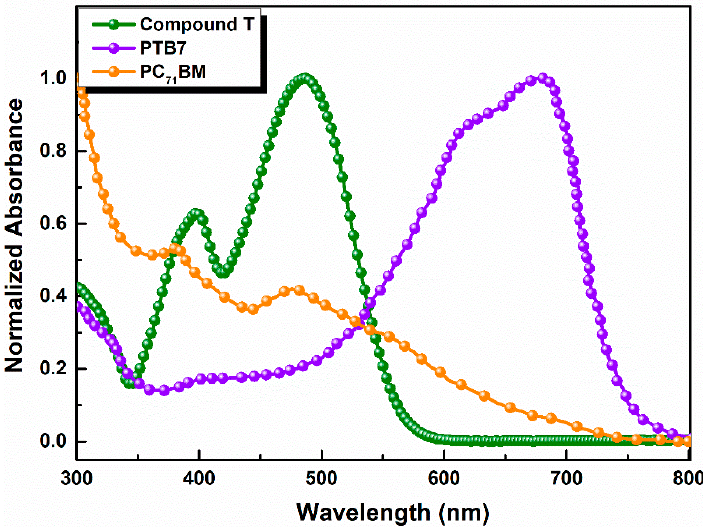
Figure 2. Normalized UV-Visible absorption spectra of Compound, PTB7 and PC 71 BM in thin films. According to the FT-IR spectrum of compound T [70] (Figure S2) a characteristic peak at 2214